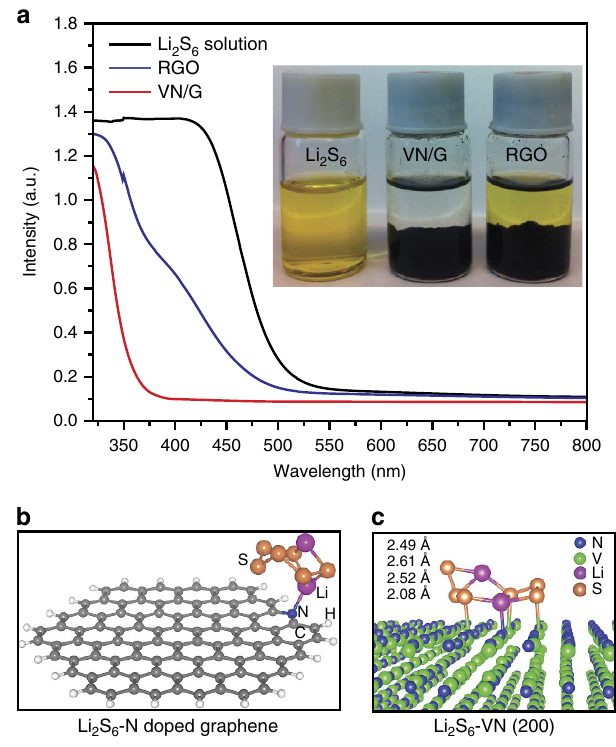
Figure 5 | Demonstration of the strong interaction of VN/G composite with polysulfides. ( a ) Ultraviolet/visible absorption spectra of a Li 2 S 6 solution before and after the addition of RGO and VN/G. Inset image shows a photograph of a Li 2 S 6 solution before and an 2h after the addition of graphene and VN/G. ( b ) Side view of a Li 2 S 6 molecule on a nitrogen-doped graphene surface, the binding energy between Li 2 S 6 and pyridinic N-doped graphene is calculated to be 1.07eV. ( c ) Side view of a Li 2 S 6 molecule on VN (200) surface, the binding energy between Li 2 S 6 and VN is calculated to be